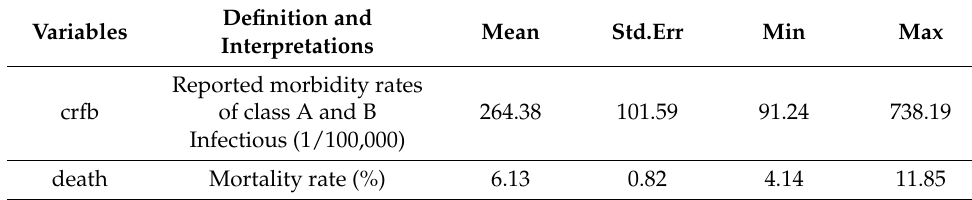
Table 1. Description of data and variables. Variables